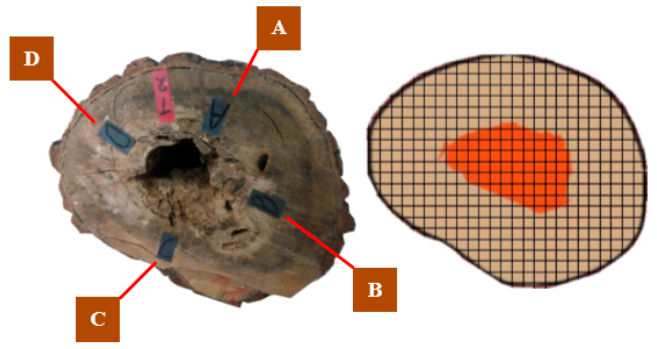
Figure 10. The thickness and area measure of samples. Table 2. Relative error of sample T1.